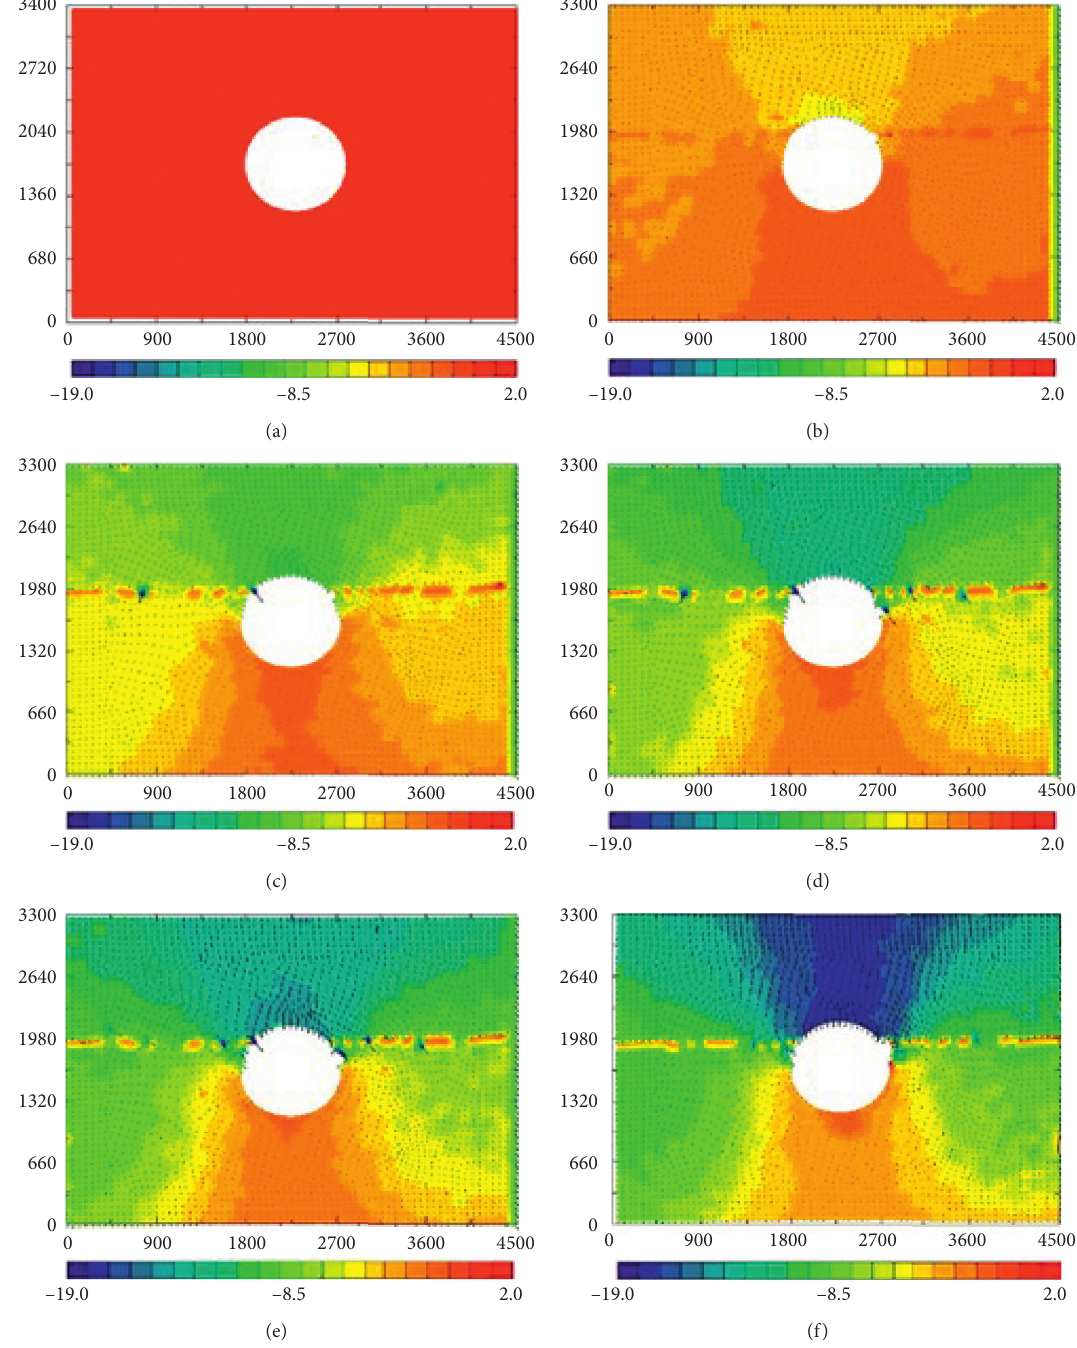
Figure 10: Vertical displacement cloud map of unsupported modes. (a) 0.25MPa. (b) 0.40MPa. (c) 0.47MPa. (d) 0.51MPa. (e) 0.52MPa. (f)